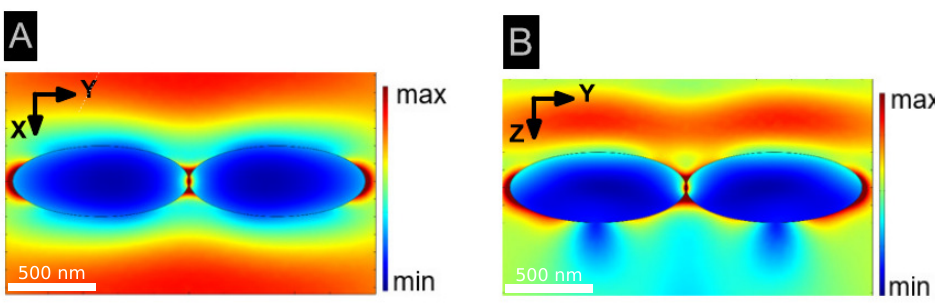
Figure 9. Electric field intensity maps at QSP maximum—980 nm in the XY-plane ( A ) and YZ-plane ( B ).